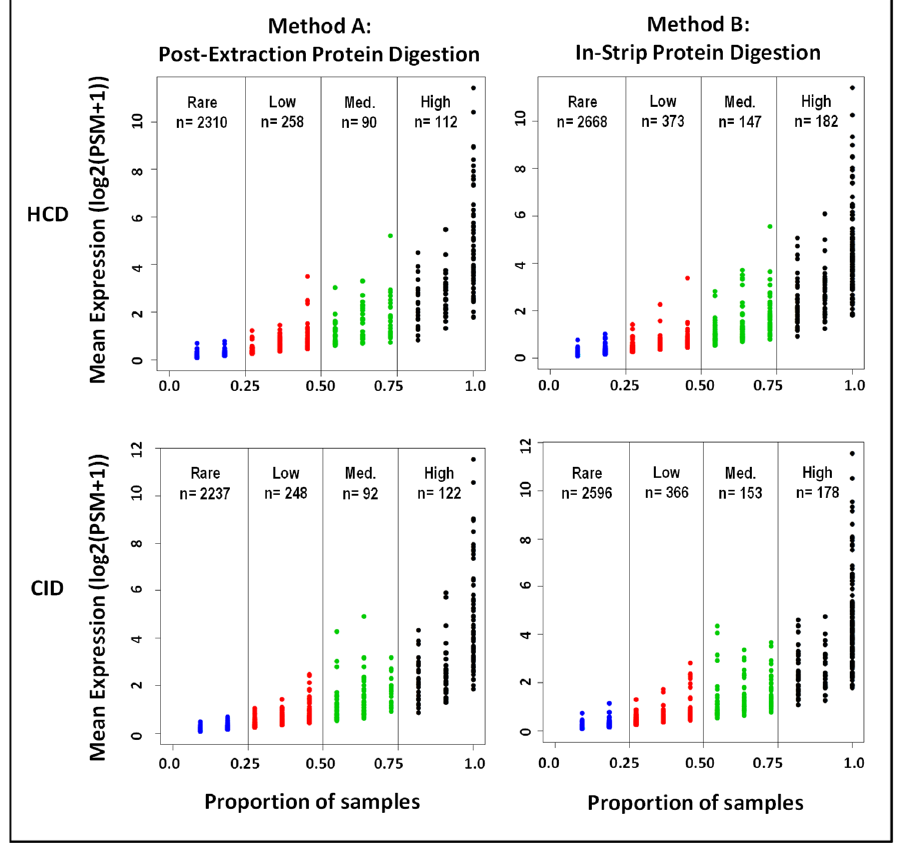
Figure 3. Distribution of mean protein expression by sample proportion in the four different work- flows. Peptide–spectrum matches (PSMs) from the 11 tear samples were log2 transformed for each digestion and fragmentation method performed to compare differences in mean protein expression between workflows. Further, proteins detected in the 11 samples were proportionally assessed and subdivided into four categories based on trends of detection for each method: High (shown in black; detected in >75% of samples), Medium (shown in green; detected in 50–75%), Low (shown in red; detected in 25–50%), and Rare (shown in blue; detected in 5–25%). Table 2. Total number of unique proteins identified in tear samples using four different